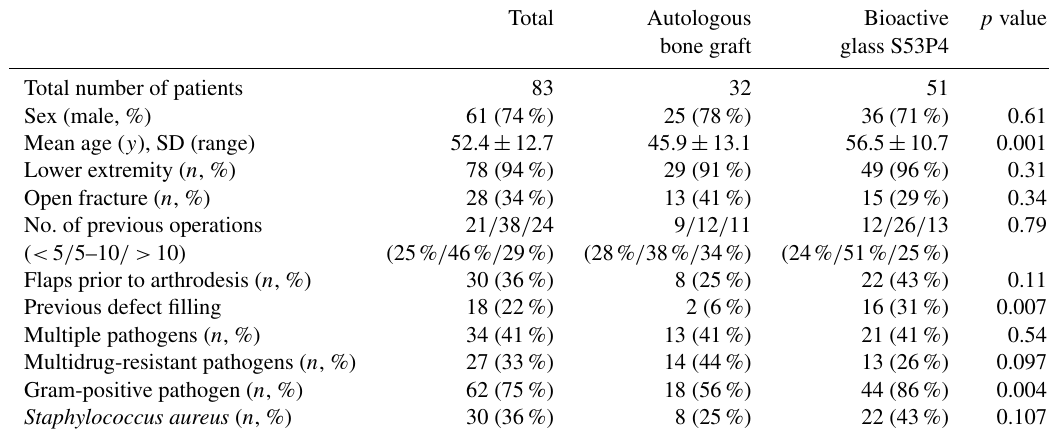
Table 1. Epidemiologic data and preoperative